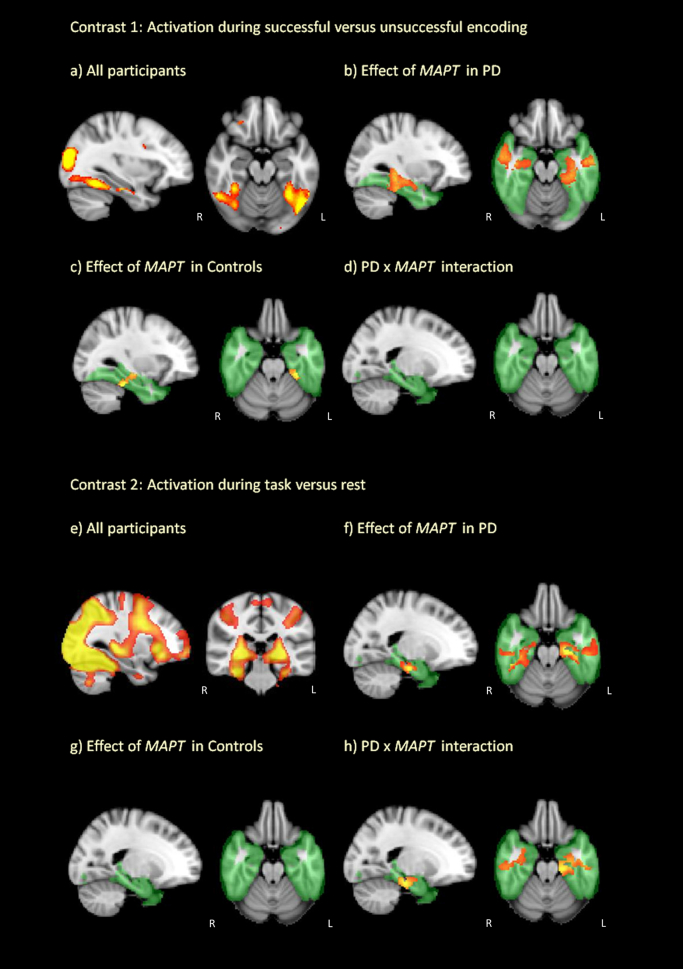
BOLD activations associated with performance of the memory encoding task. (A) Contrast 1: Activation during successful encoding (i.e. remembered minus non-remembered pictures) across all participants. (B) Effect of MAPT haplotype on Contrast 1 activation in patients with PD. (C) Effect of MAPT haplotype on Contrast 1 activation in control subjects. (D) Interaction between MAPT haplotype and PD (PD patients vs. control subjects) on Contrast 1 activation. (E) Contrast 2: Activation during overall task performance minus rest across all participants. (F) Effect of MAPT haplotype on Contrast 2 activation in patients with PD. (G) Effect of MAPT haplotype on Contrast 2 activation in control subjects. (H) Interaction between MAPT haplotype and PD (PD patients vs. control subjects) on Contrast 2 activation. All effects of MAPT correspond with increased activation in H2 carriers compared with H1 homozygotes (H1/H1). Activation that survived permutation-based cluster correction (p < 0.05 FWE corrected) within a predefined inclusive mask of the temporal lobe region of interest (green) is displayed. Abbreviations: BOLD, blood-oxygen level-dependent; PD, Parkinson's disease.